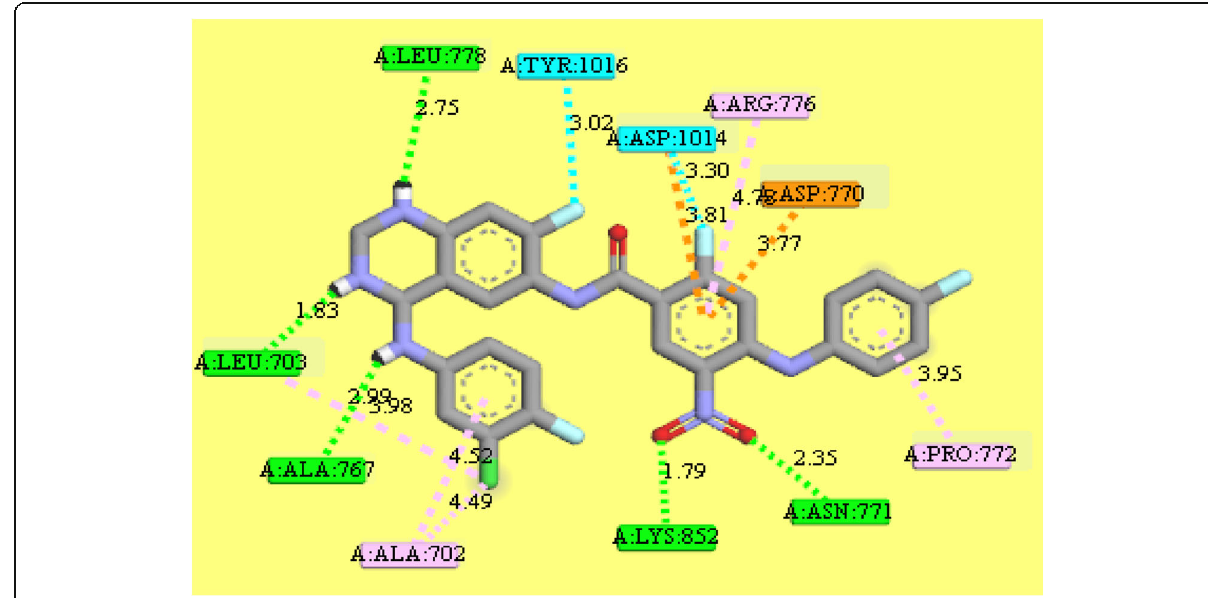
Fig. 5 2D structures of the SDD3 receptor using discovery studio